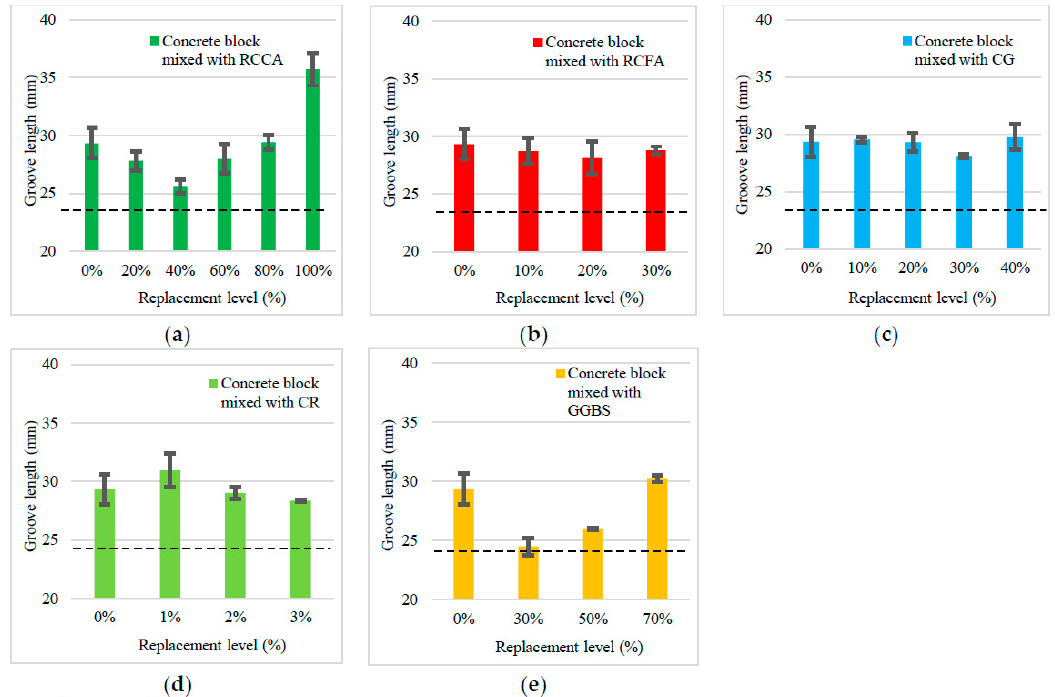
Figure 11. Relationship between the different replacement levels of materials and the maximum groove lengths of specimens.